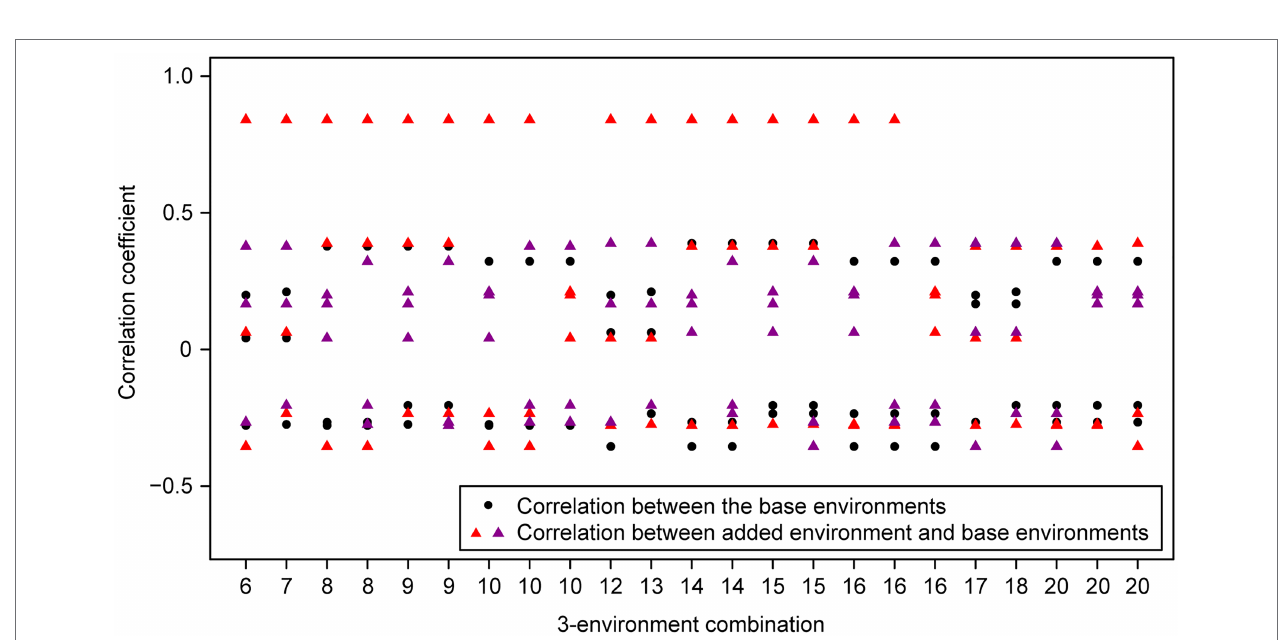
FIGURE 4 | Wheat – 3-environment combinations with complete phenotypic values showing statistically significant ( p < 0.05) lower response to selection than their extended 5-environment combinations using genomics-assisted sparse phenotyping. Labels of horizontal axis are the scenario numbers of 3-environment combinations. Black dots represent correlation coefficients between the three base environments with complete phenotypic values. Triangles with different colors indicate correlation coefficients between separate added environments, i.e., the first or second added environment, and base environments.